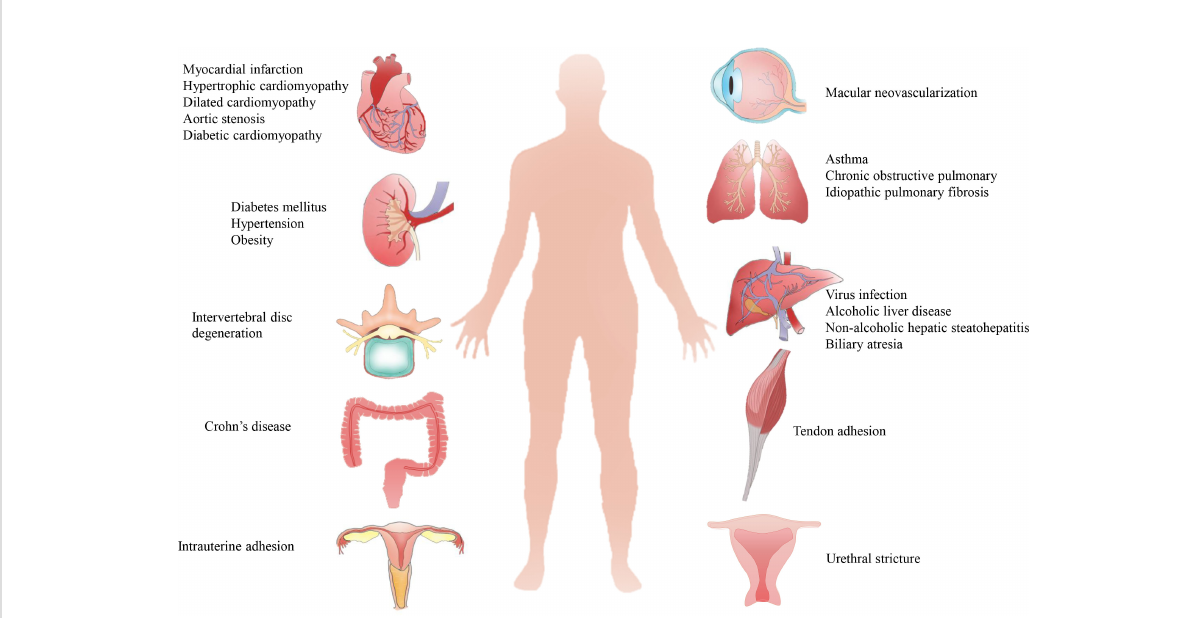
FIGURE 1 Pathological causes of organ fi brosis. Fibrosis can occur in most organs or tissues, such as the heart, liver, lung, kidney, tendon, intrauterine and intervertebral disc, due to complicated pathological